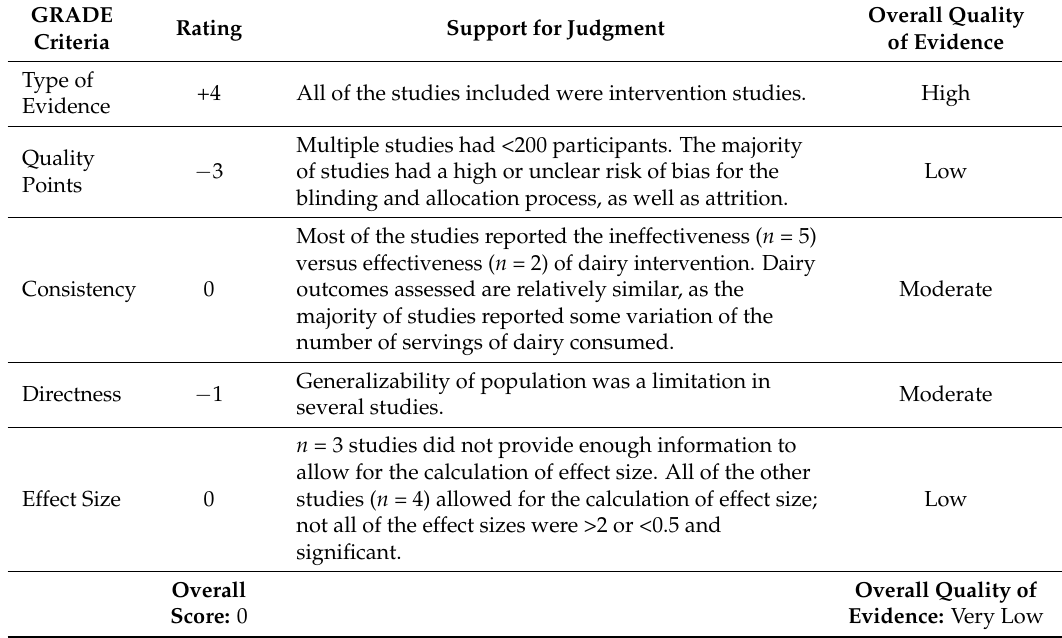
Table 6. Summary of Grades of Recommendation, Assessment, Development and Evaluation (GRADE) results for total dairy intake outcome ( n = 7). Intervention studies evaluated: Akil 2013 [22]; Cason 2001 [19]; Harvey 2008 [24]; Kopetsky 2017 [25]; O’Sullivan et al., 2016 [29]; Roberts-Gray et al., 2016 [30]; and Seward et al., 2018 [20].